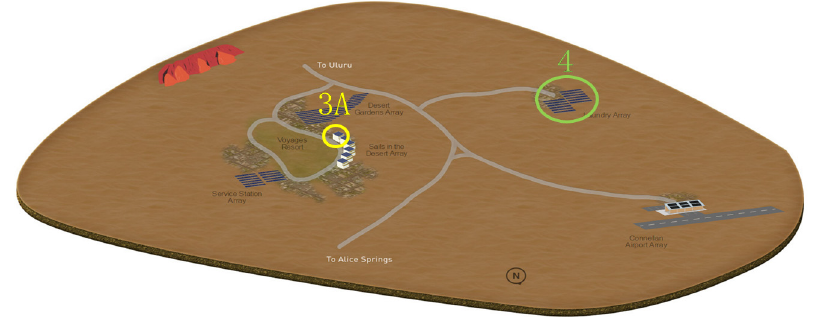
Figure 1. The map of the two systems.